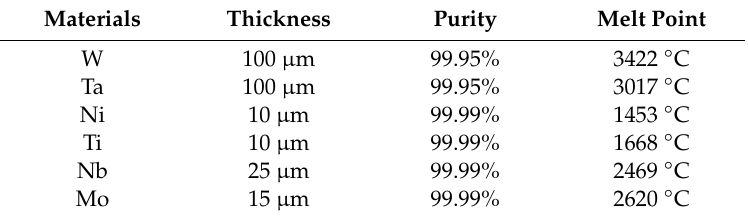
Table 1. The vendor specifications and properties of matrix and di ff erent transition layers.